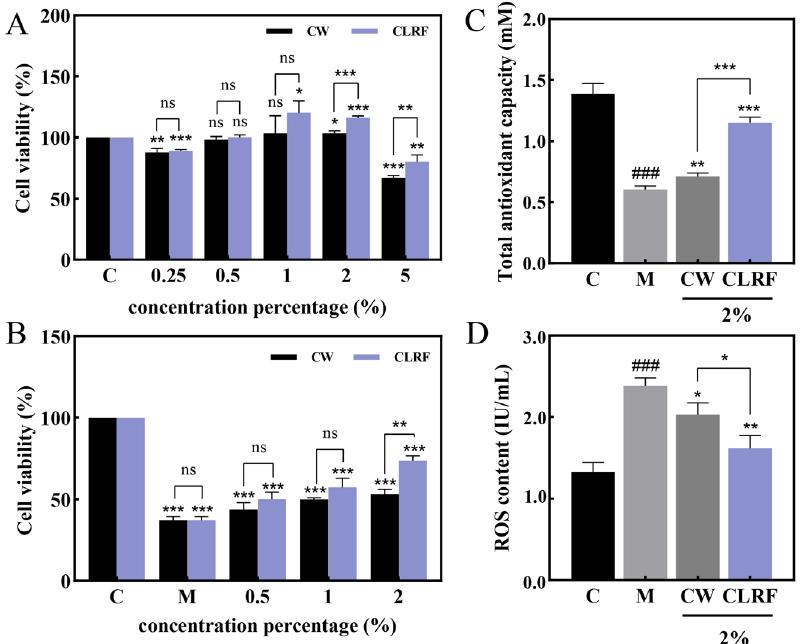
Figure 3. Effects of CLRF and CW on HSF cells viability total antioxidant capacity and ROS con- tent: ( A ) Effects of different concentrations of CLRF and CW on cell viability; ( B ) Protective effects of different concentrations of CLRF and CW on HSF cells after H 2 O 2 -induced damage; ( C ) To- tal antioxidant capacity of CLRF and CW; ( D ) Ability of CLRF and CW to scavenge ROS. CW: Coix seed water extract; CLRF: Coix seed Lactobacillus reuteri fermentation broth; C: control group; M: H 2 O 2 damage model group. Each value is expressed as mean ± SD ( n = 3). (*: p < 0.05, **: p < 0.01, ***: p < 0.001, ns > 0.05, versus model group, ###: p < 0.001, versus control